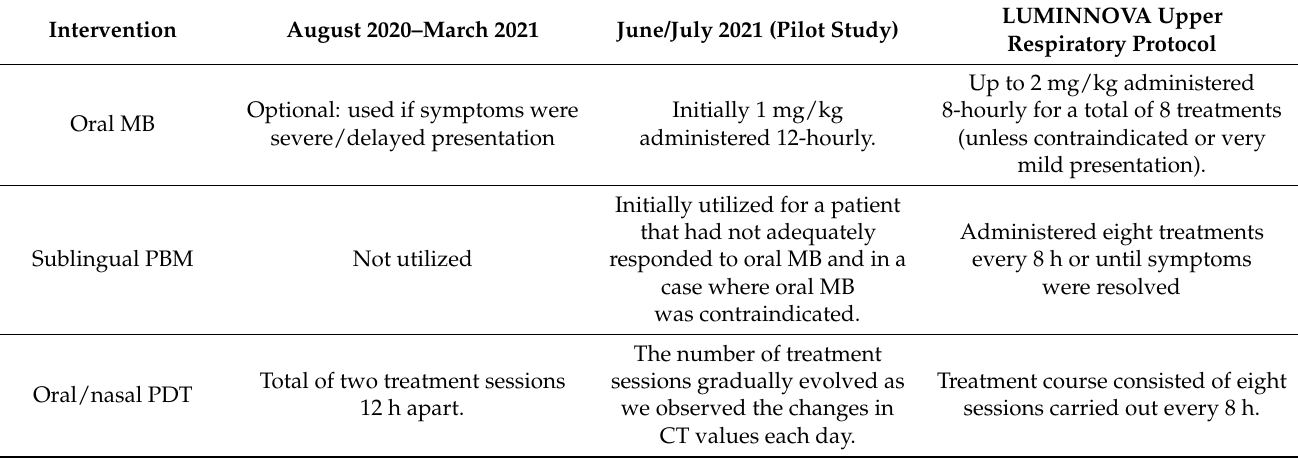
Table 4. Evolution of COVID-19 Treatment Protocol from August 2020 to July